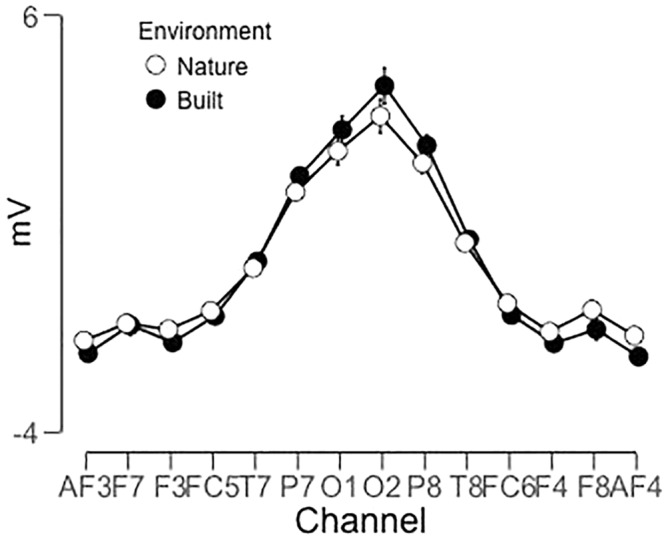
Environment × Channel interaction showing difference in polarity between posterior and frontal channels [F(4.36,257.34) = 4.36, p < 0.01, ηp2 = 0.07].